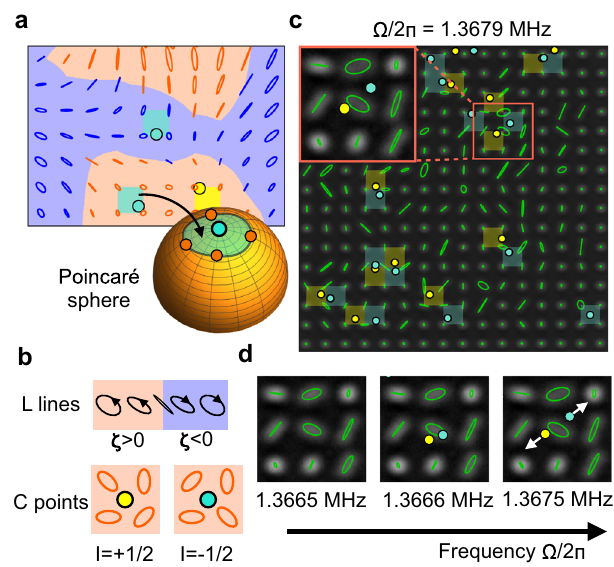
Fig. 5 Topological singularities in mechanical polarization patterns. a , b Illustration of L lines and C points as topological singularities in a simulated motion pattern (with disorder level reduced compared to the experiment for easier visualization). A plaquette likely contains a C point if it maps to a patch on the Poincaré sphere that encloses the pole. c Experimentally observed pattern with algorithmically suggested candidates of C points (Supplementary Note 9 and Supplementary Figs.